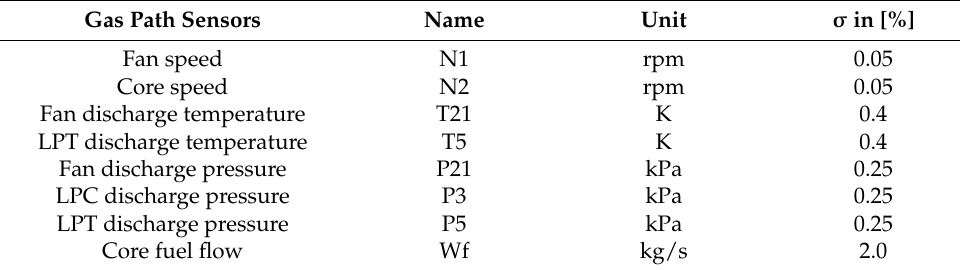
Table 2. Gas turbine sensors.